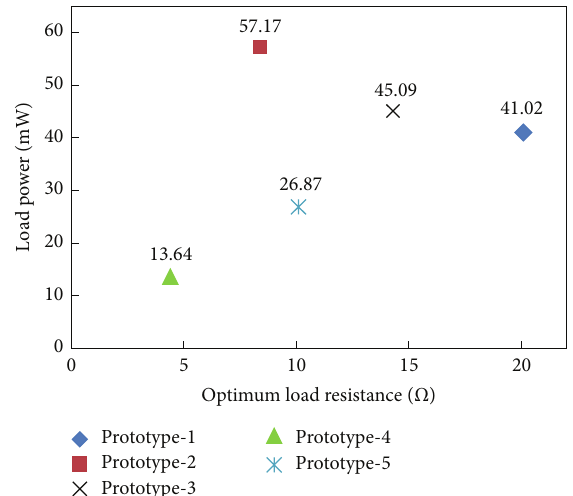
Figure 20: Load power in inductive energy harvesters as a function of optimum load resistance at 155A.